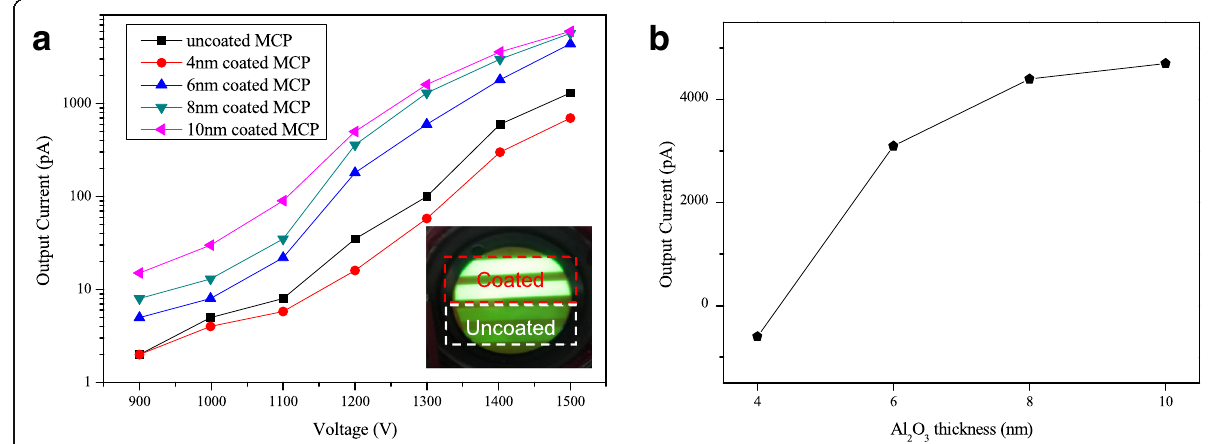
Fig. 7 Output current and image of traditional MCP and coated ALD-MCP. a Output current of different coated thickness of Al2O3 on MCP and photograph of a phosphor screen illuminated by half coated 8-nm Al2O3 and half uncoated. b Output current of coated subtract uncoated MCP as function of Al2O3